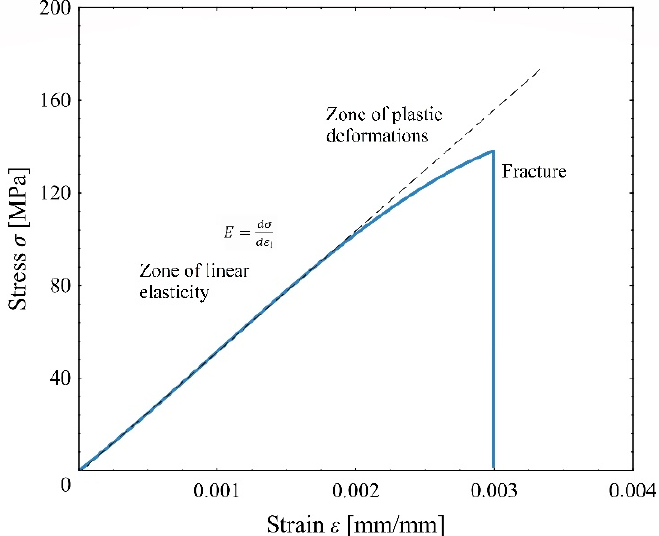
Figure 8. The diagram showing stress σ versus strain ε dependency during quasi-static loading of the rock sample 11. At the first stage the linear section is observed corresponding to the elastic strain, then plastic deformations are observed until the samples is fractured.